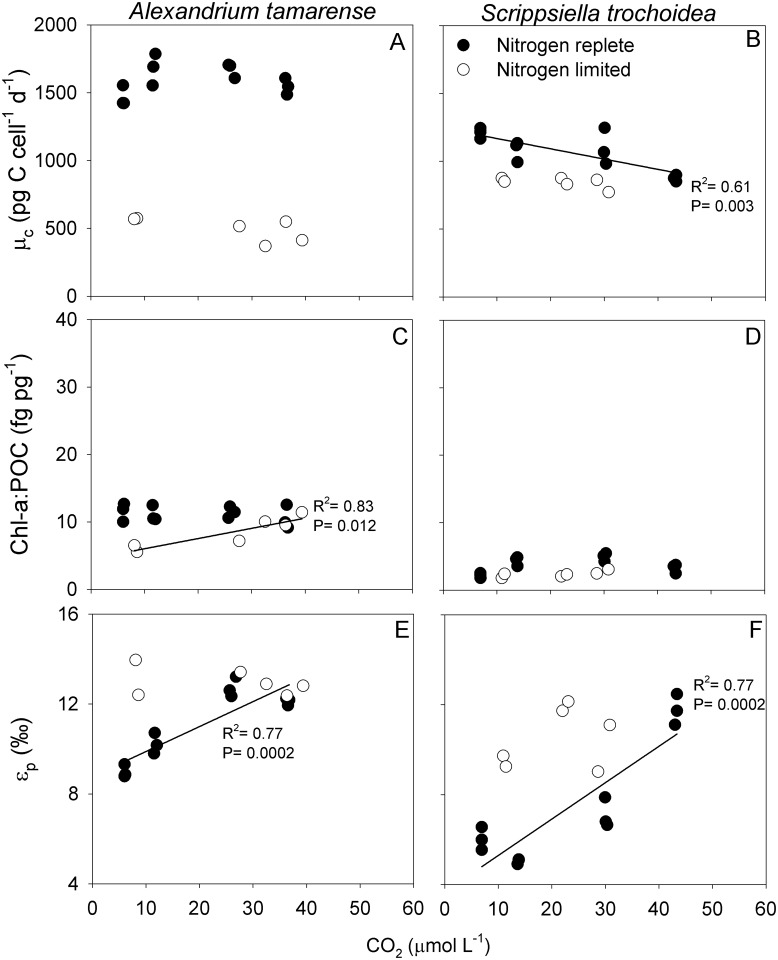
Combined effect of elevated pCO2 and nitrogen-limitation.(A, B) POC production, (C, D) Chl-a:POC ratios and (E, F) εp versus CO2 of A. fundyense (left) and S. trochoidea (right) cultured under nitrogen-replete conditions (HN; filled symbols) and nitrogen-limited conditions (LN; open symbols). Linear trend lines, R2 and P-values represent statistically significant relationships. Symbols indicate means of technical replicates. Means ± SD for all treatments are provided in Table 2. POC production and Chl-a:POC ratios have previously been published in [15] and [18], and εp in the HN treatments in Hoins et al. 2015.